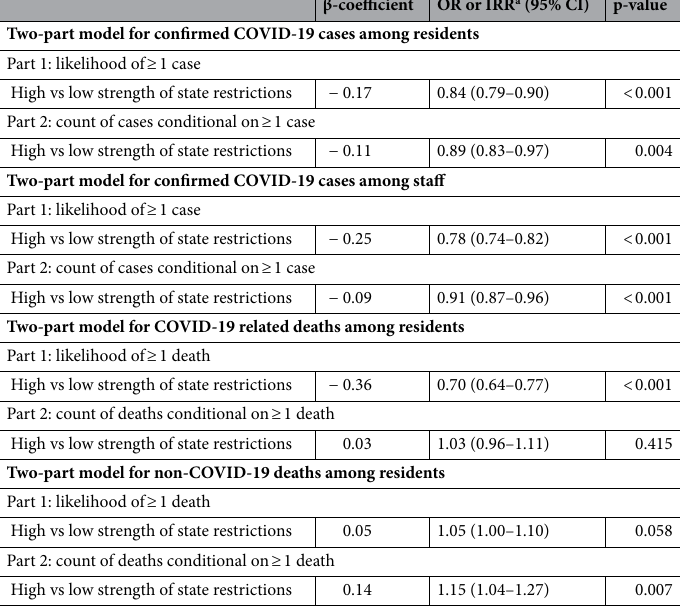
Table 2. Associations between the strength of state social distancing measures and nursing home COVID- 19 and non-COVID-19 outcomes. Based on two-part models for confirmed cases and deaths separately that adjusted for nursing home, county, and state covariates, time trend, and the clustering of repeated observations of nursing homes. OR odds ratio, IRR incidence rate ratio, 95% CI 95% confidence interval. a ORs are reported for part 1 of the two-part models and IRR are reported for part 2 of the two-part